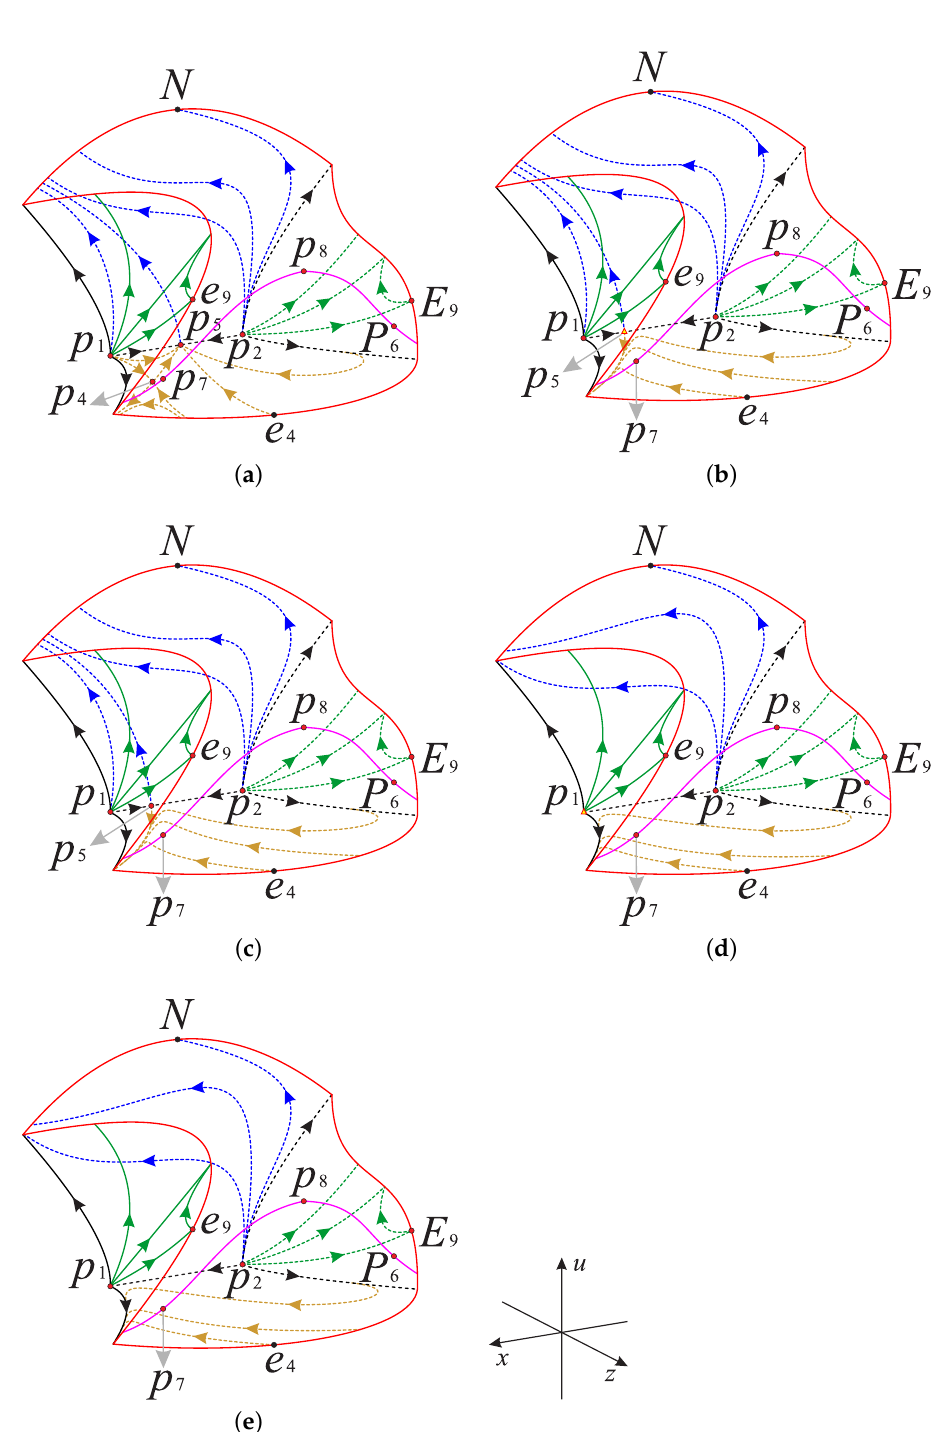
Figure 15. Phase portrait in the boundary of the region R 1 for different values of s : ( a ) 0 < s < 1, √ √ √ ( b ) s = 1, ( c ) 1 < s < 6/2, ( d ) s = 6/2, ( e ) s > 6/2. The surfaces above and below the long dashed line represent regions I and III,